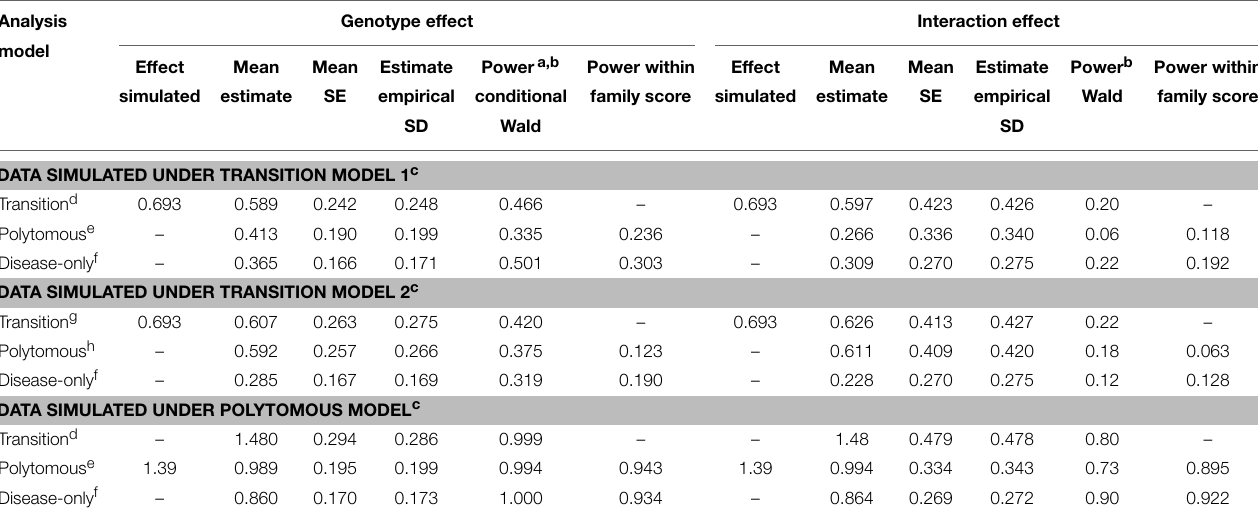
TABLE 2 | Simulation results with a dichotomous exposure.